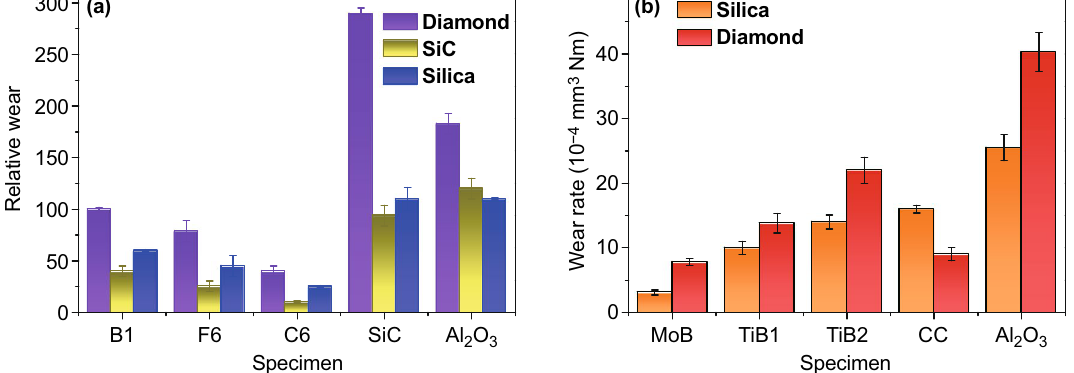
Fig. 18 a Relative wear rates for the tested materials as shown in Table 7 abraded with diamond, SiC, and silica. 100 corresponds to Bl worn with diamond [188]. b Wear rates for the different tested materials as shown in Table 8 abraded with silica and diamond [184]. Figure panels reproduced from Ref. [188] with permission from Springer Nature 1998, Ref. [184] with permission from Wiley copyright